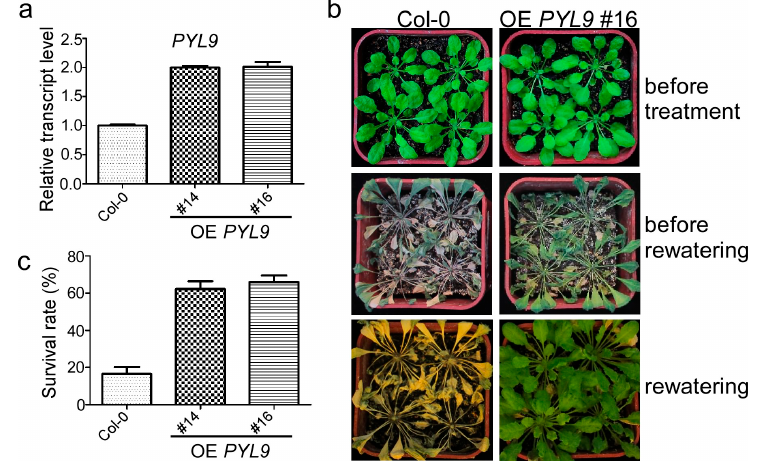
Figure 1. Overexpression of PYL9 enhanced drought tolerance in plants. ( a ) Relative transcript level of PYL9 in two transgenic lines (#14 and #16) harboring Myc-PYL9 . Data are the means ± standard errors ( n = 3). ( b ) Overexpression of PYL9 confers drought tolerance in Arabidopsis . Four-week-old transgenic plants (upper) were treated by withholding water for 30 days (middle) and then rewatered. The representative images were taken after the plants were re-watered for 10 days (lower). ( c ) The percentage of surviving plants after re-watering for ten days. Data are the means ± standard errors ( n = 24).